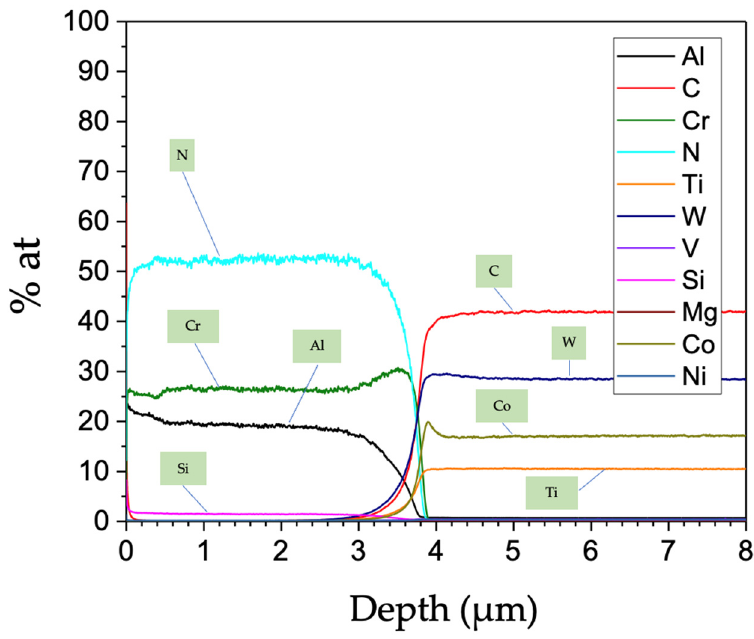
Figure 3. Glow discharge optical spectrometry (GD-OES) concentration profiles in the AlCrSiN coated WC-TiC-Co sample.